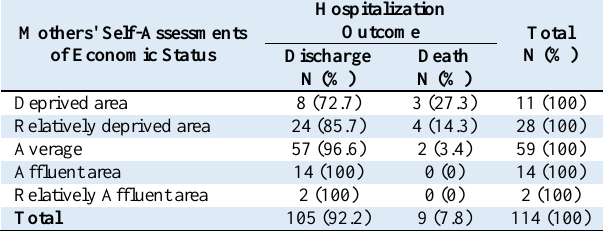
Table 5. The relationship between mothers' self-assessments of economic status and premature infant